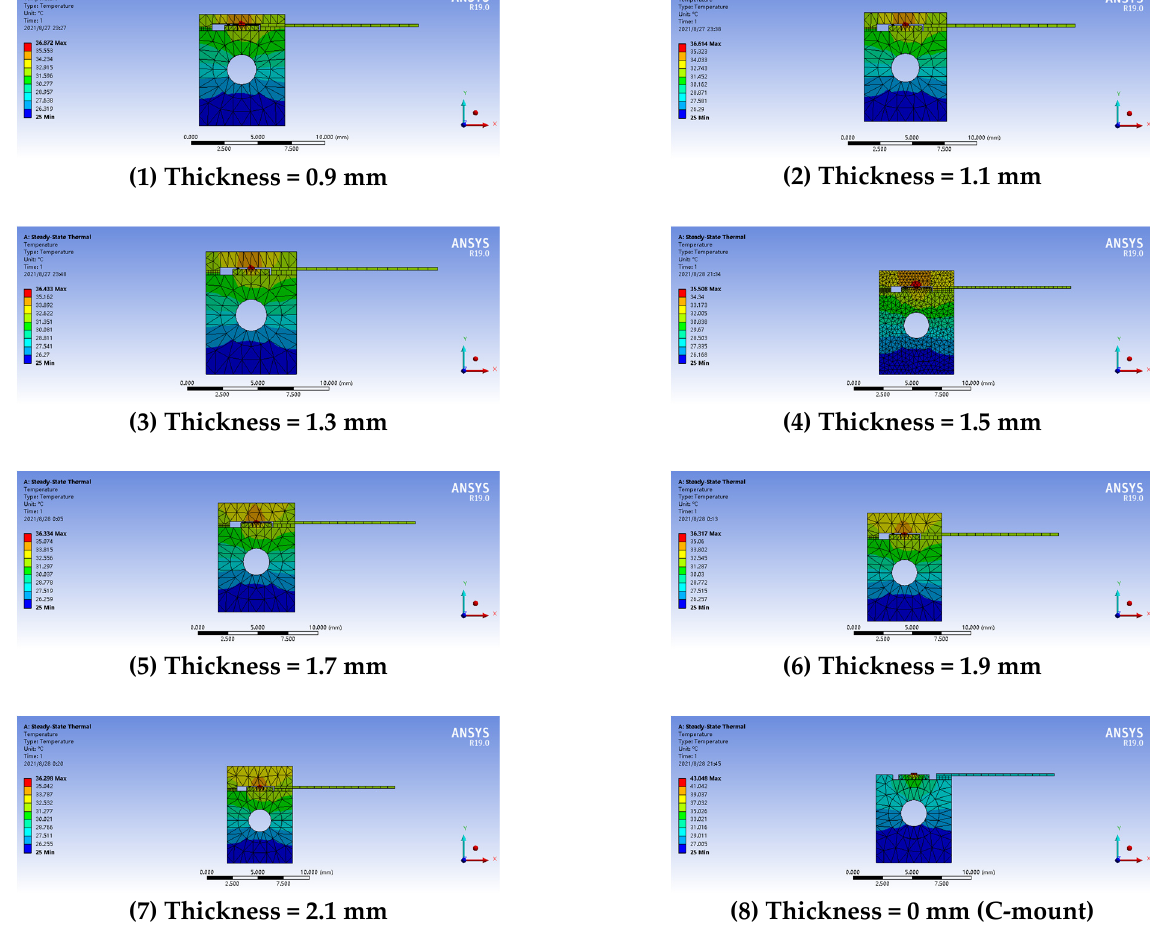
Figure 5. Comparison of thermal analyses of different heat sink sizes.